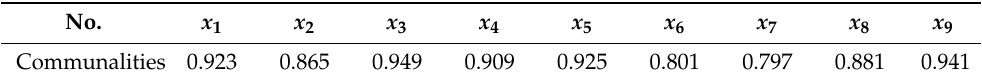
Table 4. Communalities calculation result.